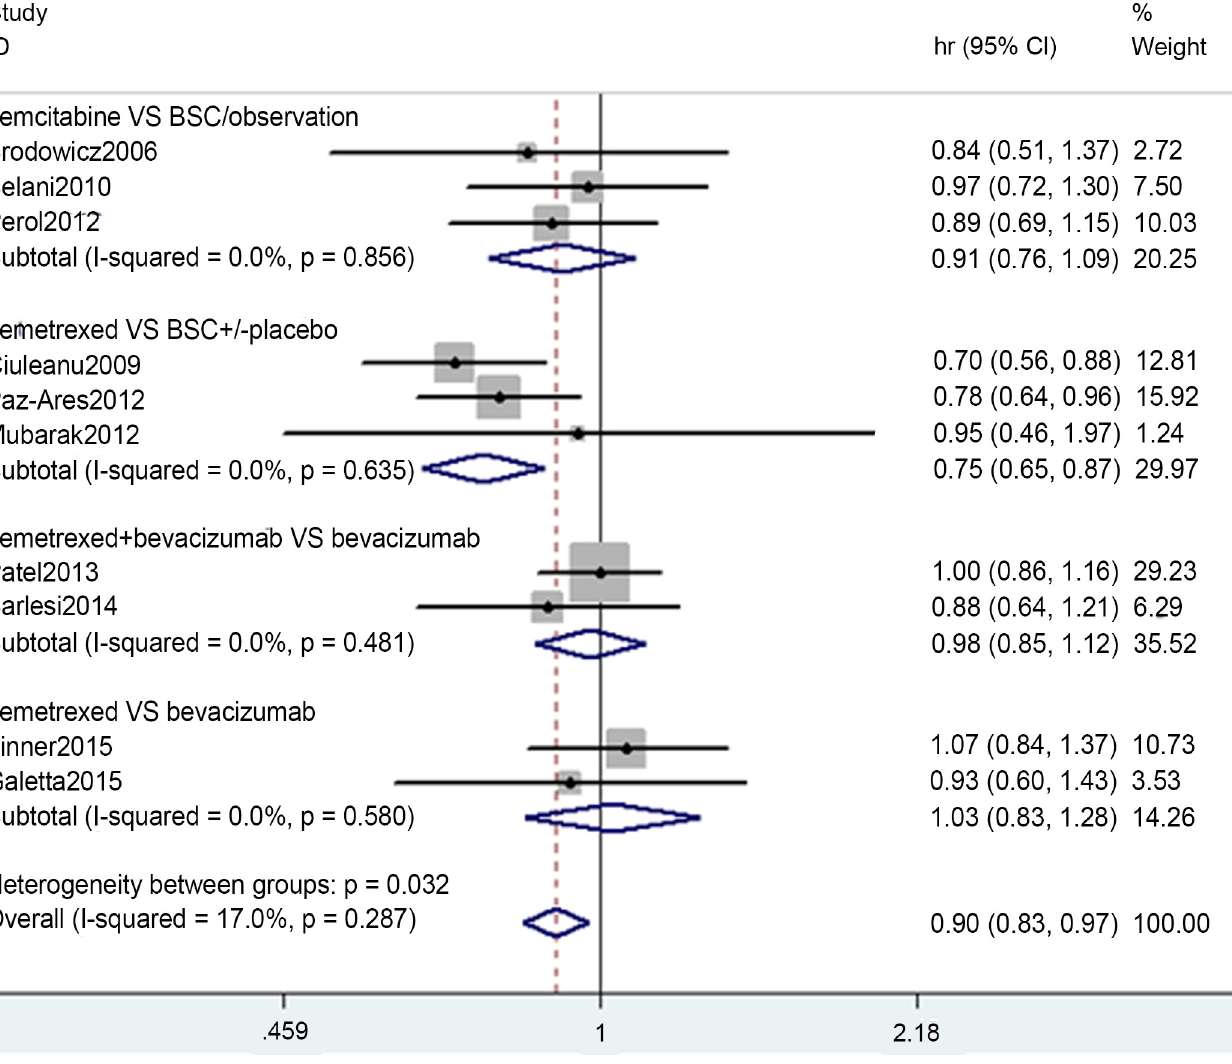
Fig 4. Meta-analysis results of